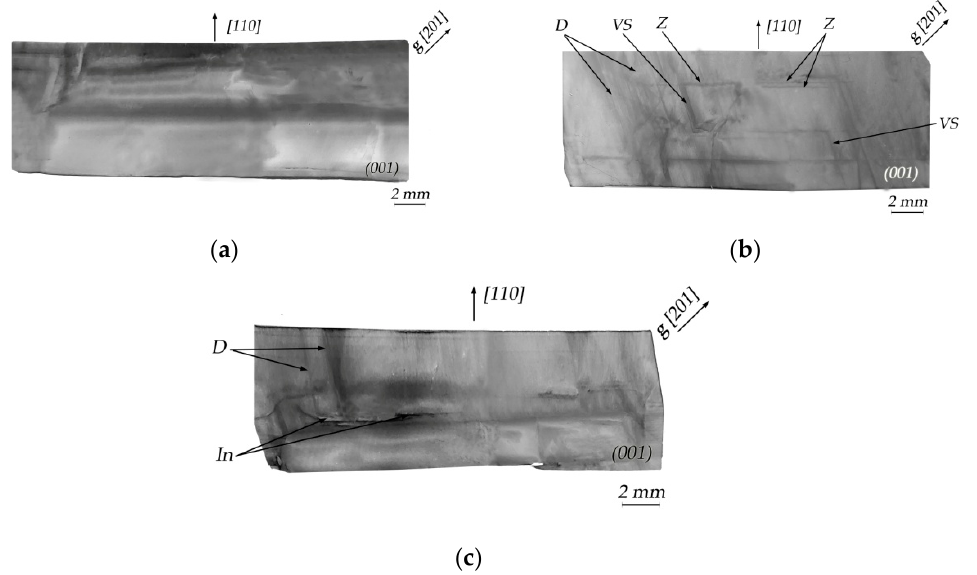
Figure 5. X-ray projection topographs of crystals #5 ( a ), #6 ( b ), and #4 ( c ). D—dislocations, Z—zonal inhomogeneities, VS—vicinal–sectorial boundaries, In—inclusions.